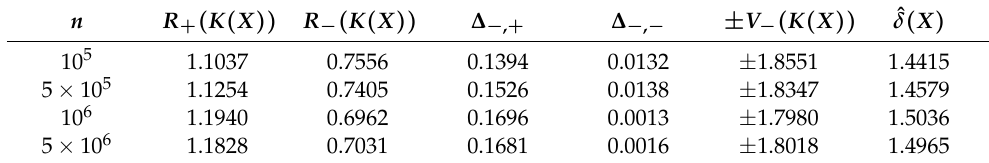
Table 3. Examples of estimates for the parameters of the model distribution GE ( 0.7; − 1.8;3.6;3.9;1.5 ) . n